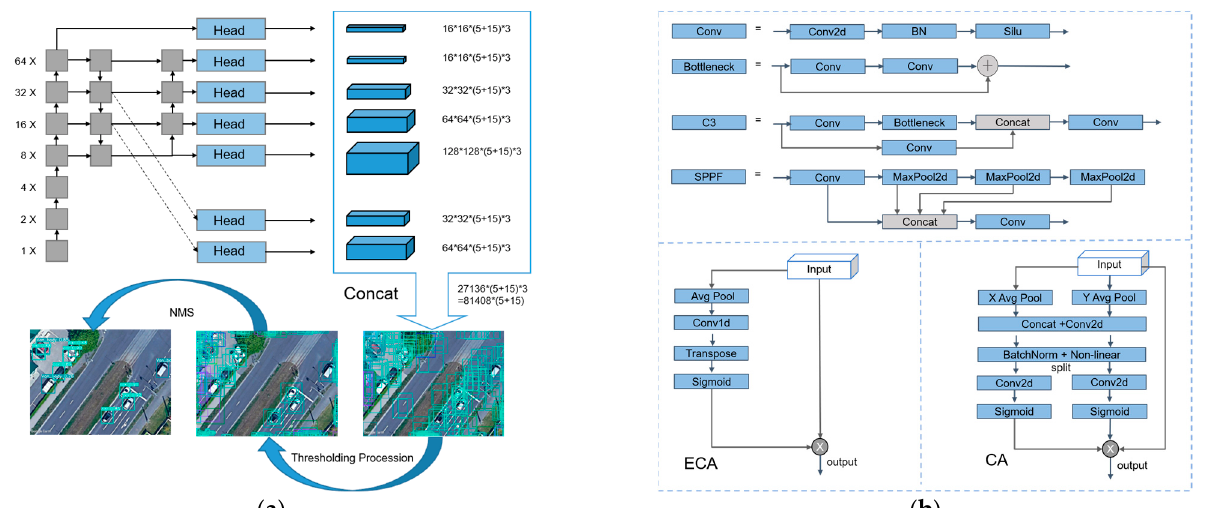
Figure 3. Composition modules of YOLO-HR. ( a ) The principle of YOLO-HR multi-head output; ( b ) the other composition modules of YOLO-HR.